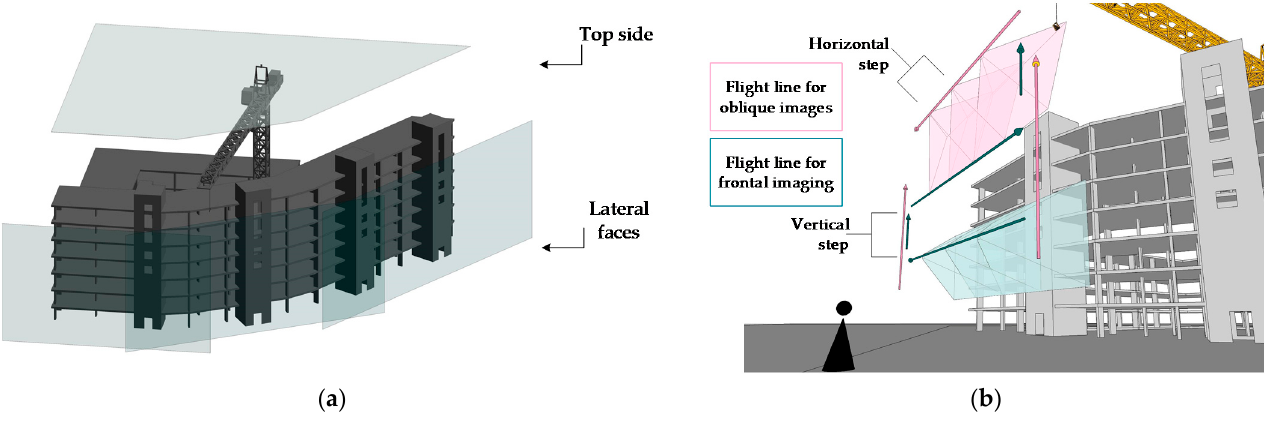
Figure 3. ( a ) Definition of the top face and lateral faces according to the shape of the structure. ( b ) Flight paths in front of each face, horizontal and vertical steps.